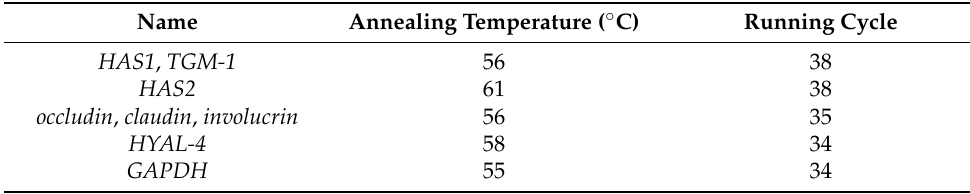
Table 2. Annealing temperatures and running cycles adopted in this